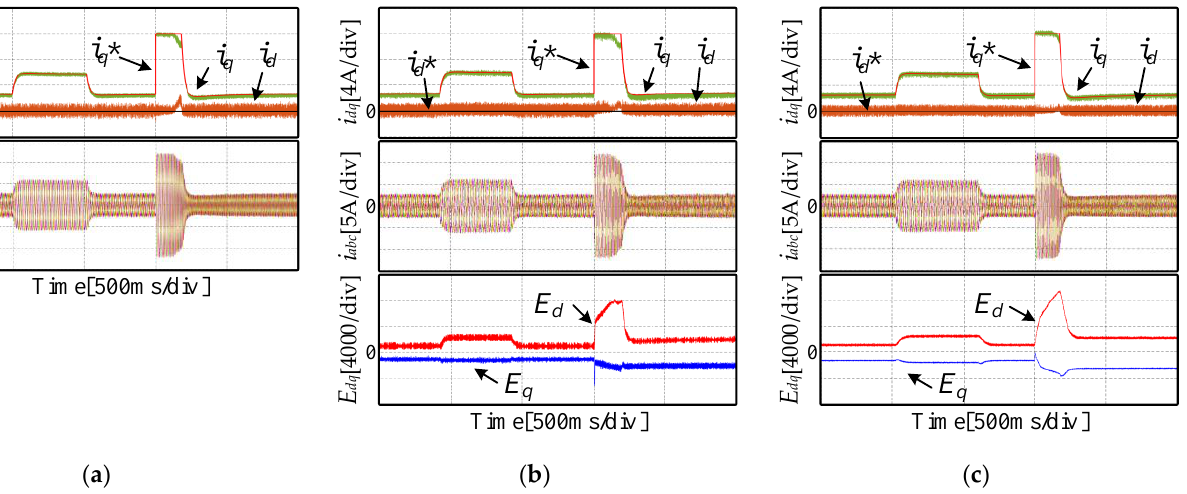
Figure 10. Experimental results of dq axis currents, phase currents and dq − axis total disturbance under dynamic working conditions: ( a ) MPCC; ( b ) CMFPCC; ( c ) IMFPCC.